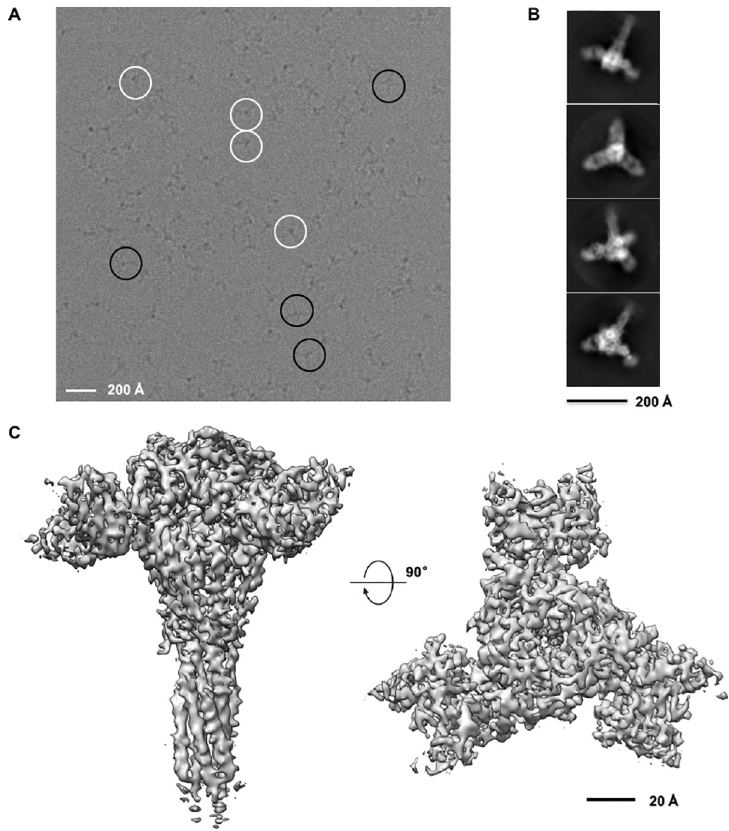
Fig 2. Cryo-EM of the purified post-fusion RSV F710 in complex with R4.C6 Fab. (A) Representative raw electron image of ice-embedded RSV F-R4.C6 complex on graphene oxide grids recorded using K2 Summit camera. White circles indicate particles with top view; black circles indicate particles with side view. Scale bar, 200 Å . The shown image is motion-corrected using MotionCor2. (B) Representative 2D class averages of the RSV F-R4.C6 Fab complex obtained by using RELION2.0. C3 symmetry is apparent in these 2D class averages. (C) Cryo-EM 3D map of R4.C6 Fv in complex with RSV F shown as side view (Left) and top view (Right). Also see S4 Fig for cryo-EM 3D reconstruction.